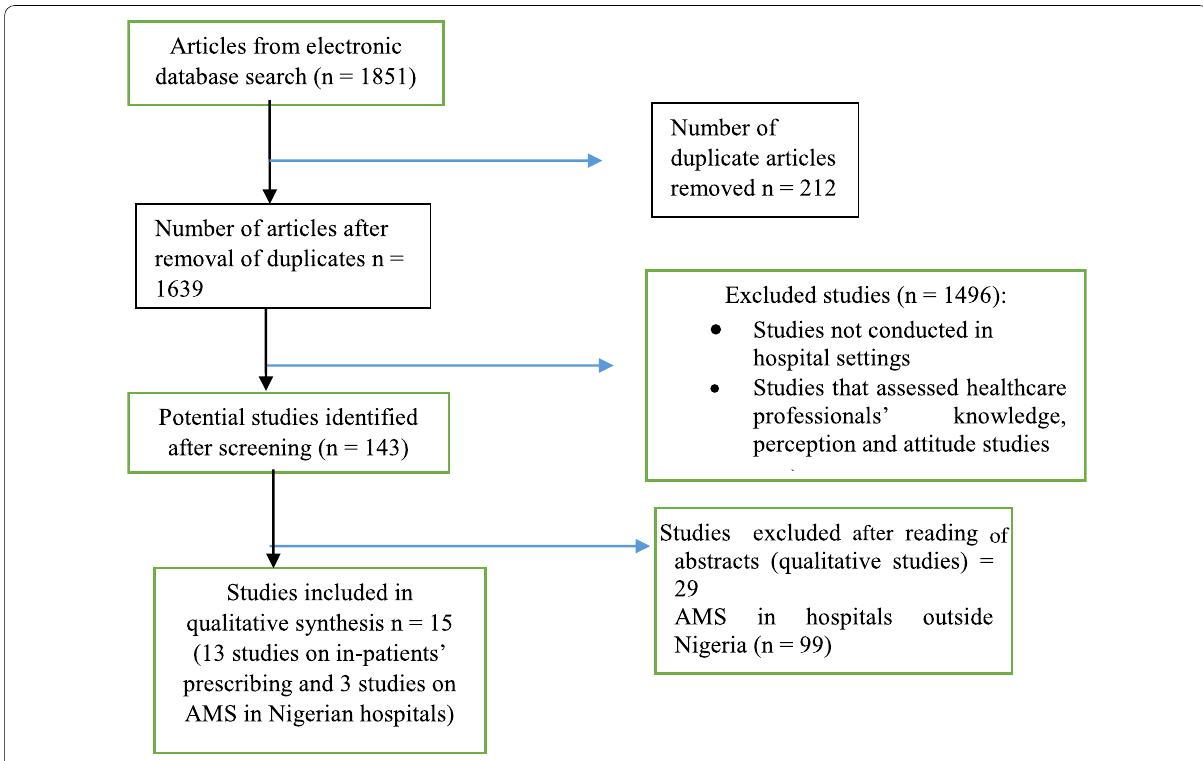
Fig. 1 PRISMA flow diagram of study